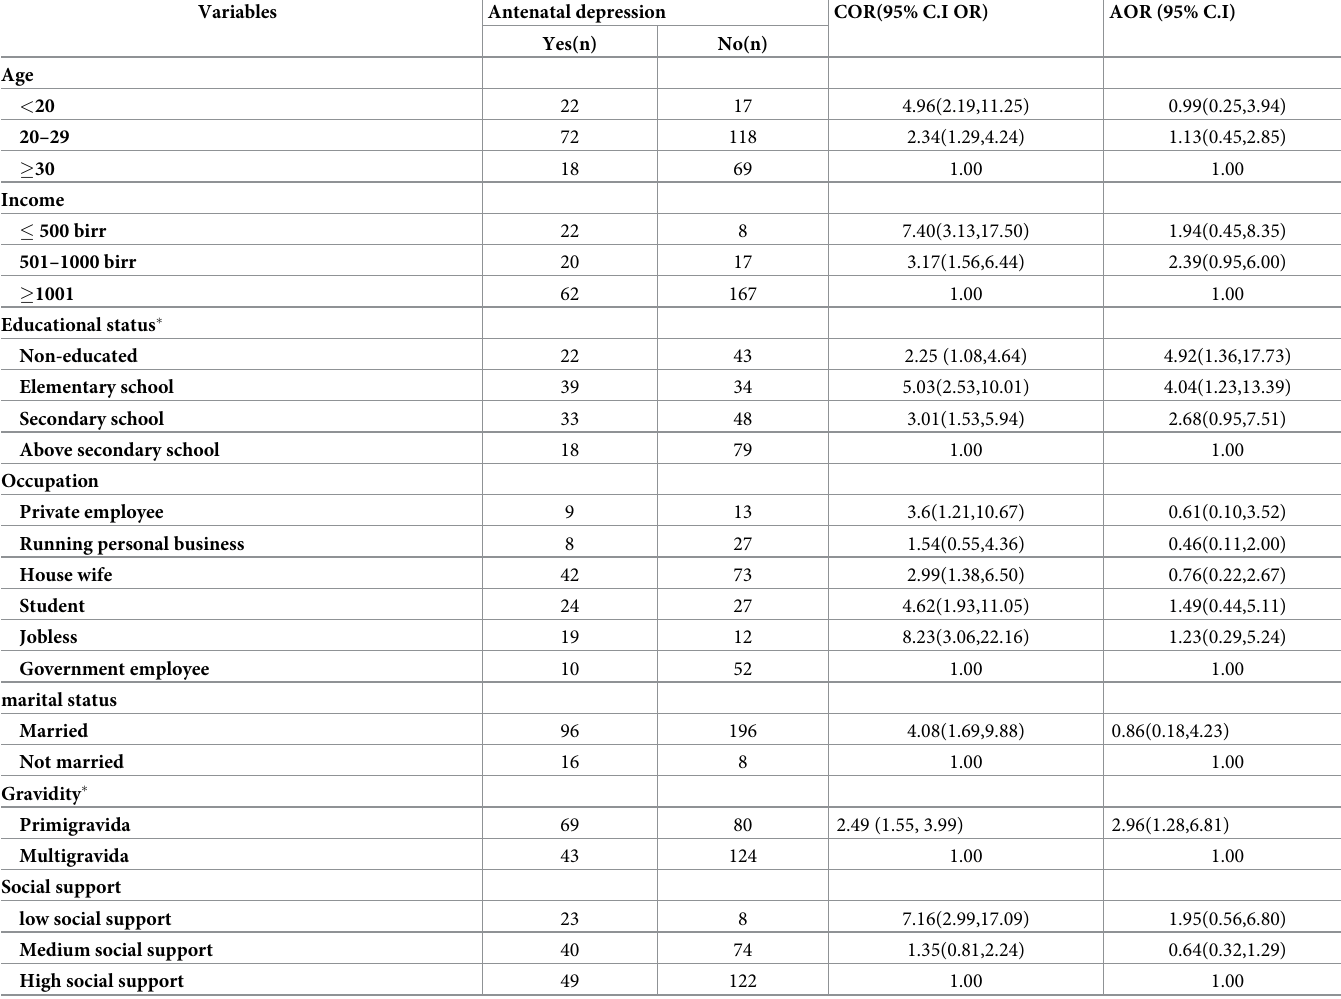
Table 5. Factors associated with depression among pregnant women attending public health facilities in Arba Minch SNNPR Ethiopia